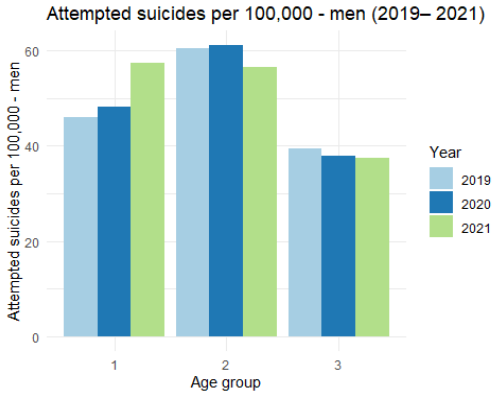
Table 4. The number of attempted suicides per 100,000 men (2019–2021).